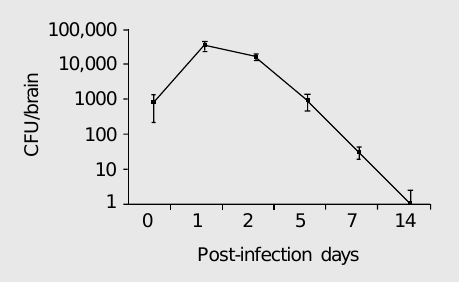
Figure 1. Growth and clearance of Nocardia otitidiscaviarum (GAM-5) in the brains of NMRI mice inoculated with 5 x 10 6 colony forming units (CFU). Data are reported as means ± SD. Note that the ordinate scale is